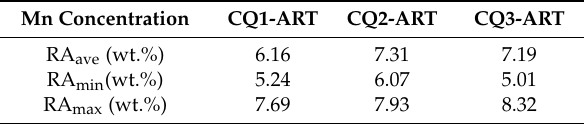
Table 3. Data of Mn concentration in retained austenite by